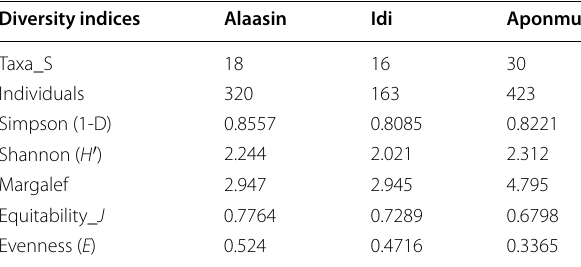
Table 2 Diversity indices of Odonata collected from three sites along River Aponmu in Ipogun